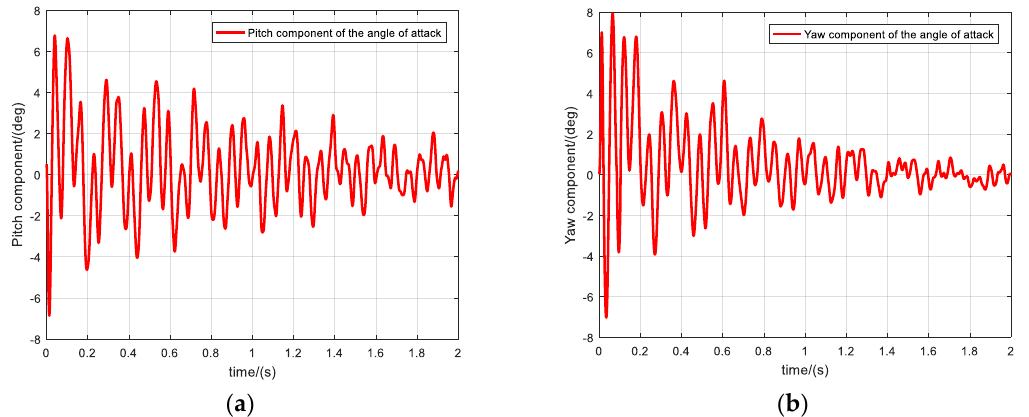
Figure 18. Pitch and yaw components of the attack angle. ( a ) Pitch component of the attack angle, ( b )